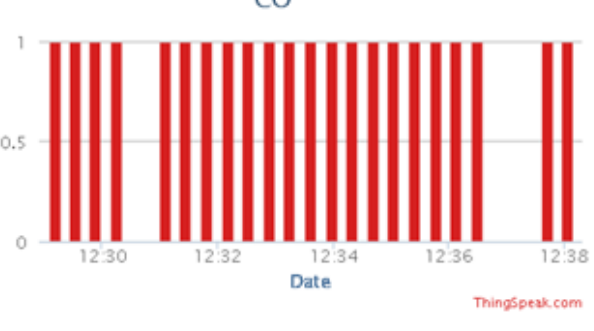
Figure 16. CO level. Figure 16. CO